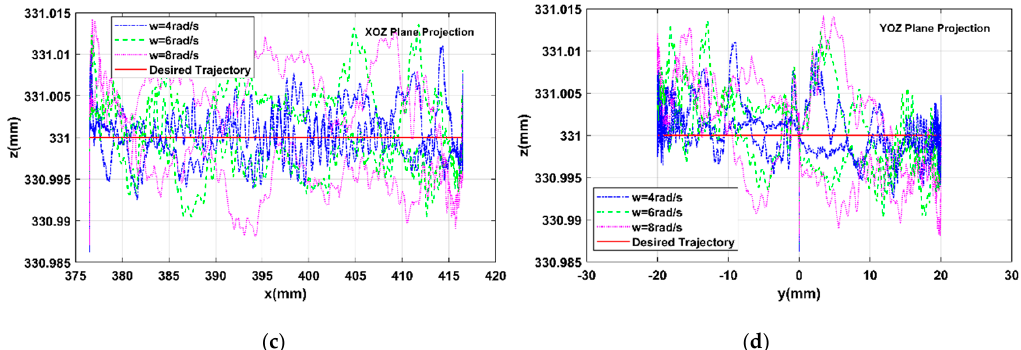
Figure 12. Robot end-point Cartesian feedforward forward controller at different speeds. ( a ) 3D image; ( b ) XOY planar projection; ( c ) XOZ planar projection; ( d ) YOZ planar projection.